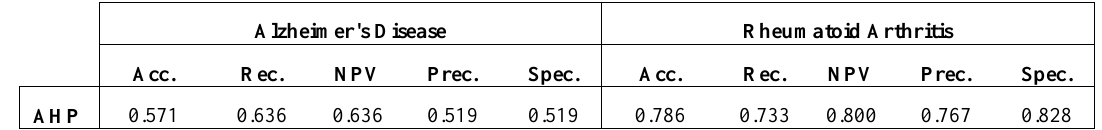
Table 13. 5-fold Cross Validation results for AHP based prioritized list of SNPs over disease trait for AD and RA data.